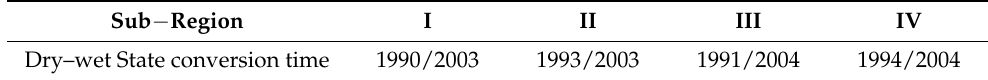
Table 2. Dry–wet state conversion time in different sub −